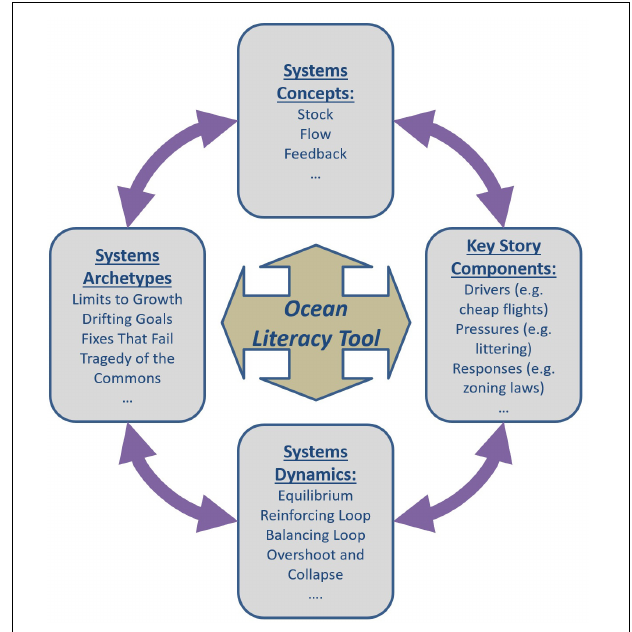
FIGURE 2 | Systems Thinking and Key Story concept map.